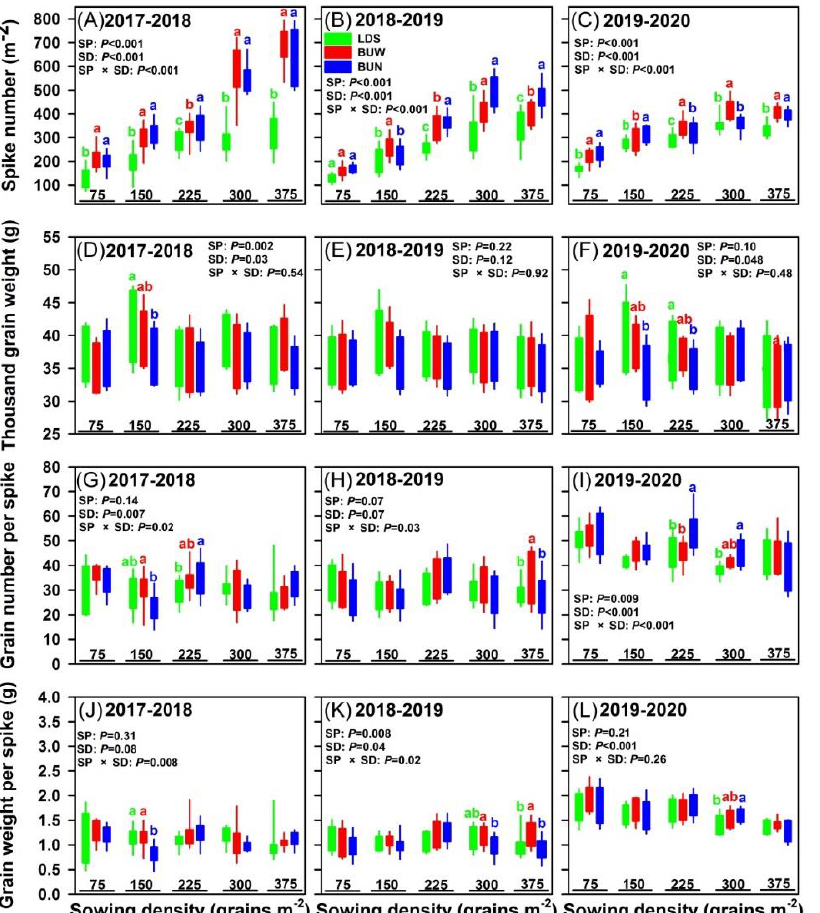
Figure 3. The changes of the ( A – C ) spike number (g m −2 ), ( D – F ) thousand-grain weight (g m −2 ), ( G – I ) seed number per spike, and ( J – L ) grain weight per spike under three sowing patterns (SP; line and dense sowing with 33.3 cm row spacing (LDS); belt uniform sowing with 20 cm row spacing (BUW); and belt uniform sowing with 15 cm row spacing (BUN)) and five sowing density (SD; 75, 150, 225, 300, and 375 plants m −2 ) in the three consecutive growing seasons. The different letters mean significant difference between the sowing patters at the same sowing density.